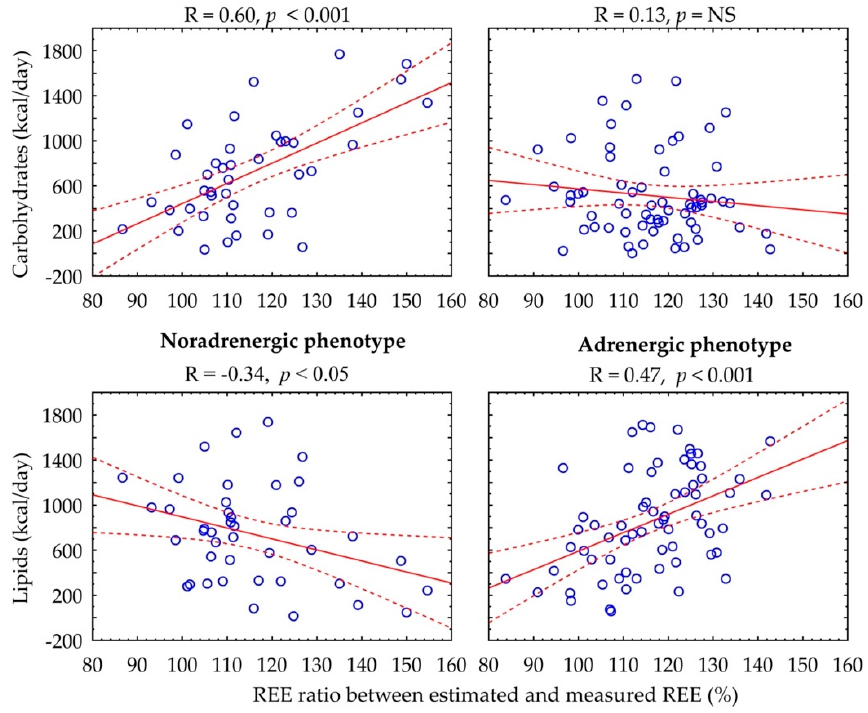
Figure 2. Correlation between carbohydrate and lipid rates and percentage of REE ratio according to catecholamine phenotype. catecholamine